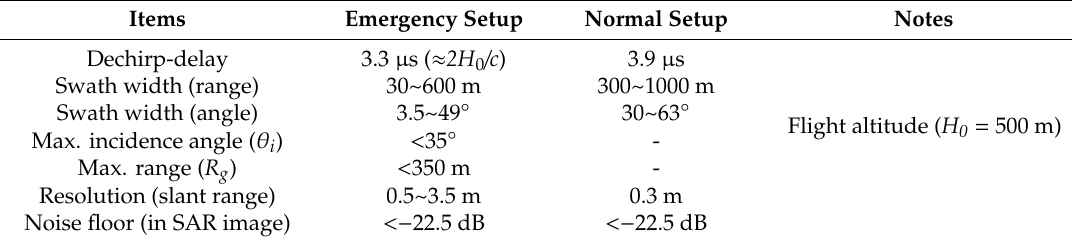
Table 2. Summary of performance comparison (emergency vs. normal